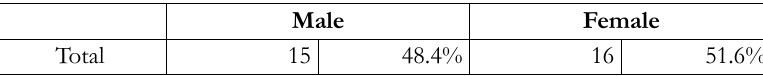
Table 1. Sample of